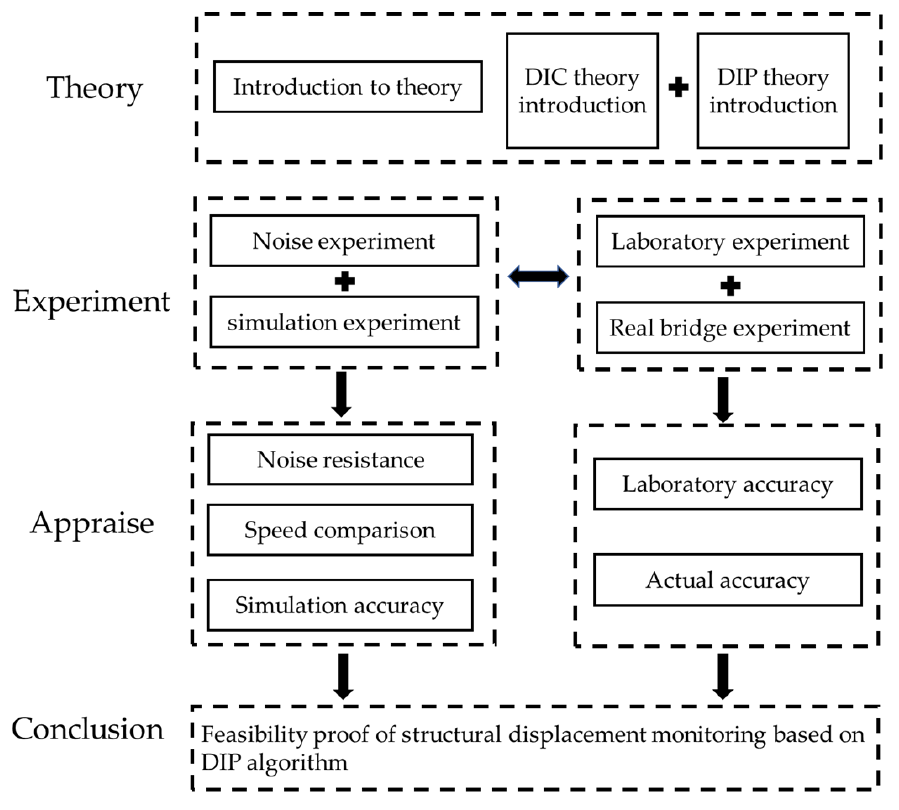
Figure 1. The structure of this article.